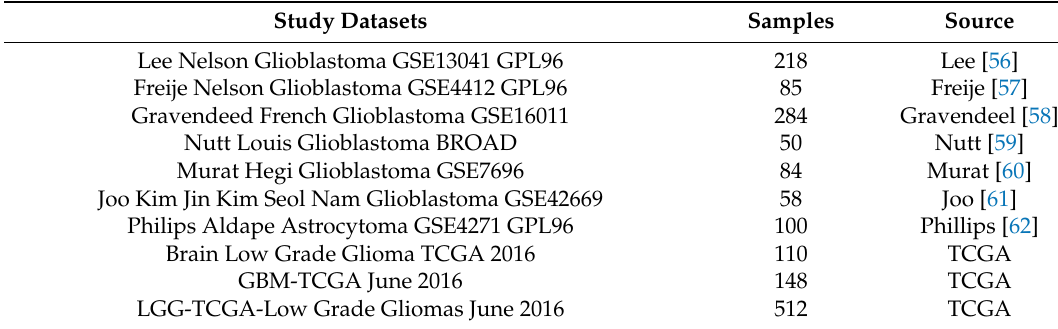
Table 5. List of glioblastoma studies used in survival prognosis validation using the gene set discovered by deep learning.